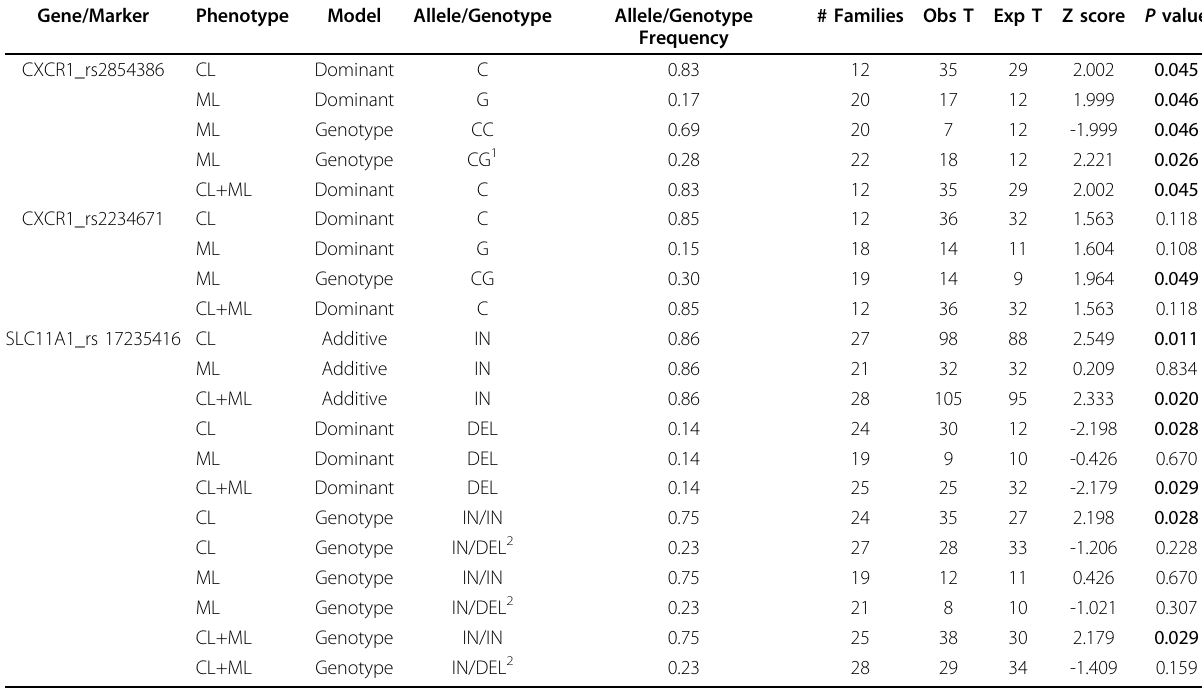
Table 3 FBAT analysis of family data